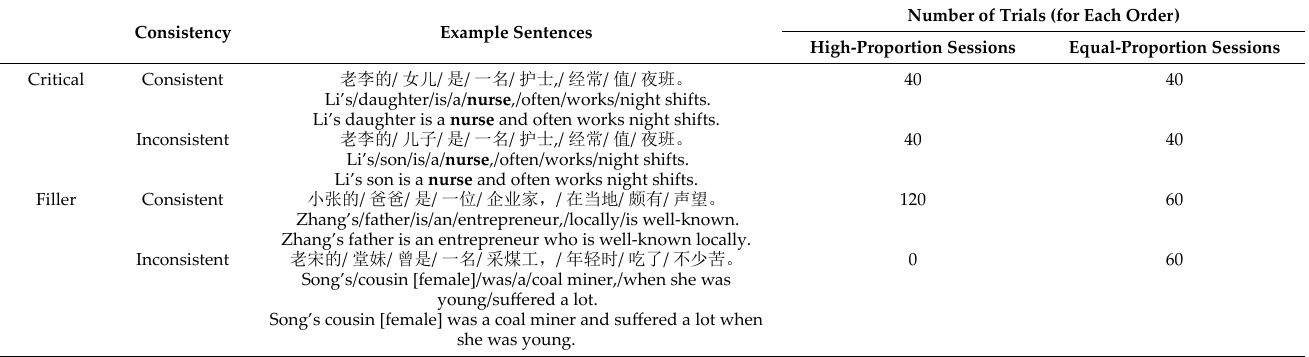
Table 1. Examples for four types of sentences in the event‑related potential (ERP) experiment, to‑ gether with the corresponding number of trials for both high‑proportion and equal‑proportion ses‑ sions. Examples are given in Chinese, with English glosses and translations. The critical words are in